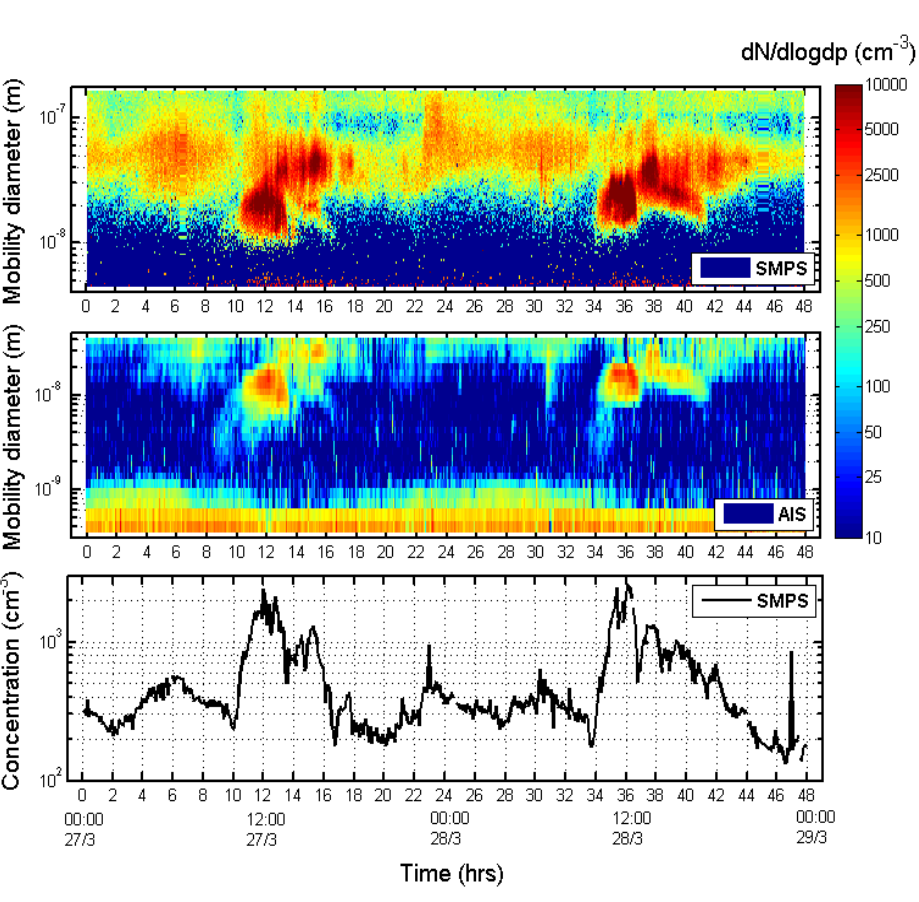
Fig. 4. Contour plots of the AIS and SMPS data and a time series of particle concentration (4 < d < 165nm) for 27 and 28 March 2007. Legends indicate the instrument that measured the data in each graph. AIS data shown is for negative ions, the graph for positive ions looks very